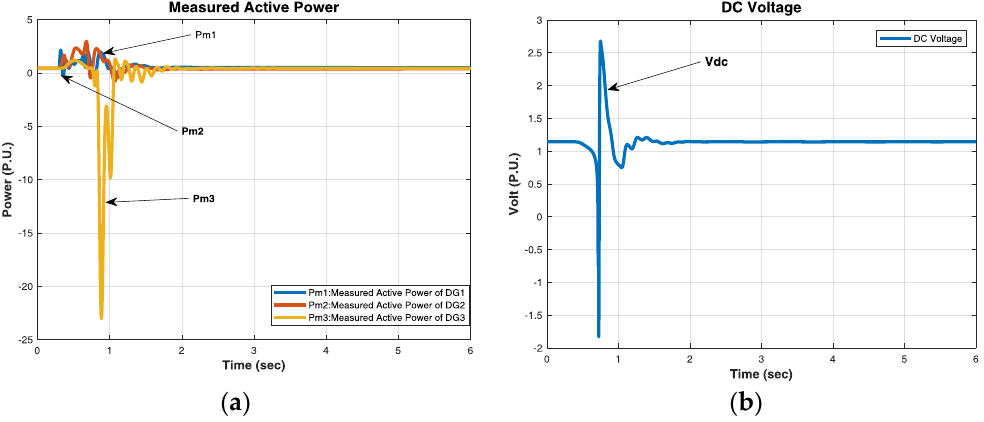
Figure 10. Microgrid response when active load voltage stepped down to 0.5pu.